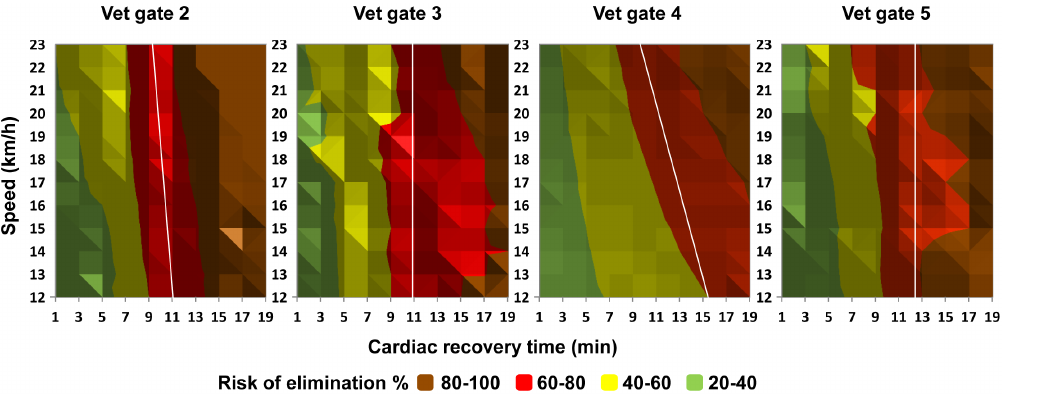
Fig 4. Three-dimensional scatter plots showing the probability of elimination at vet gates 2, 3, 4 and 5, according to the corresponding logistic regressions with a fixed HR of 64 and the AS and CRT measured at the previous vet gate (n-1). Red corresponds to a probability of elimination of 60 to 80%, whereas brown (the darkest areas) corresponds to a probability of 80 to 100%. The white line corresponds to a probability of elimination of 70% (the threshold chosen to compute the probability of elimination in an independent data set used for